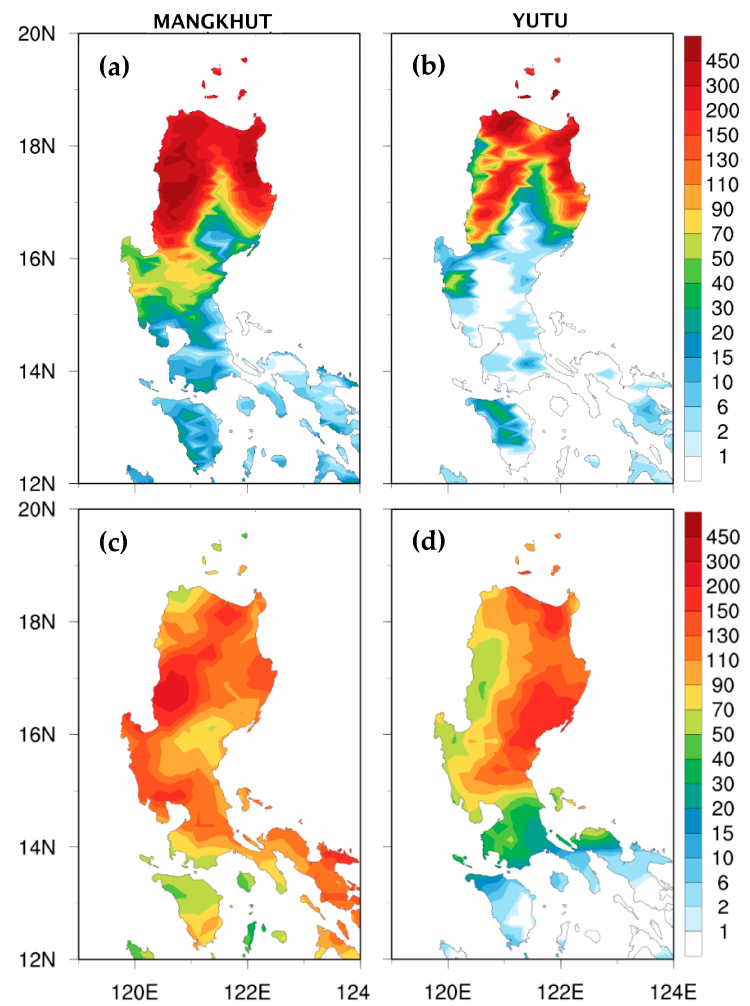
Figure 8. The 48 h accumulated rainfall (color shaded in mm) (from 0000 UTC 13 to 0000 UTC 15 September 2018) for ( a ) MK-CTL and ( c ) observation rainfall from TRMM_3B42_Daily. ( b ) and ( d ) are the same as in ( a ) and ( c ), respectively, but for Yutu from 0000 UTC 29 to 0000 UTC 31 October 2018.